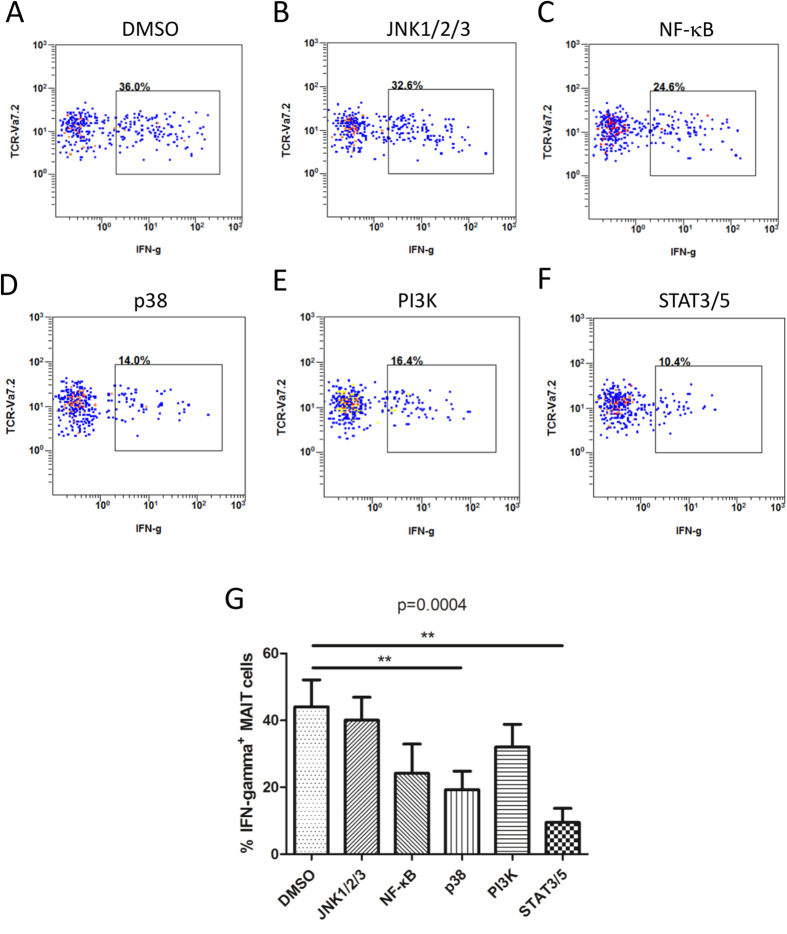
Blockade of signaling pathways with small molecule inhibitors.(A–F) Representative flow plots showing IFN-γ production in Mtb-stimulated MAIT cells in the presence of solvent DMSO (A), or small molecule inhibitors to JNK1/2/3 (B), NF-κB (C), p38 (D), PI3K (E), or STAT3/STAT5 (F). (G) Inhibition effect of small molecule inhibitors on IFN-γ production in Mtb-stimulated MAIT cells from tuberculous pleural effusions (n = 8). The Friedman’s test (p = 0.0004), followed by Dunn’s multiple comparison test was used for statistical analysis among groups. **p < 0.01.